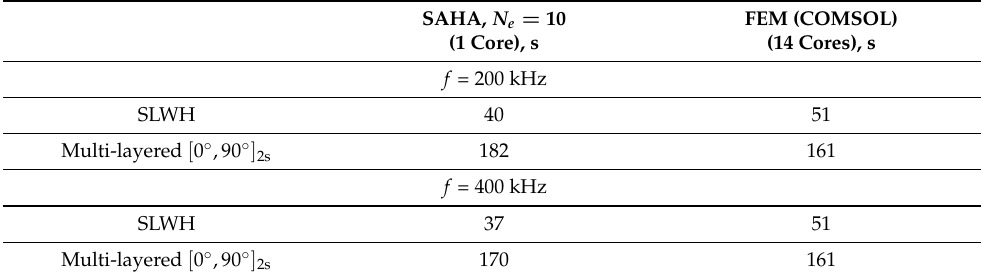
Table 5. Computational times for the waveguide [ 0 ◦ ,90 ◦ ] 2s with two PWTs, in seconds.